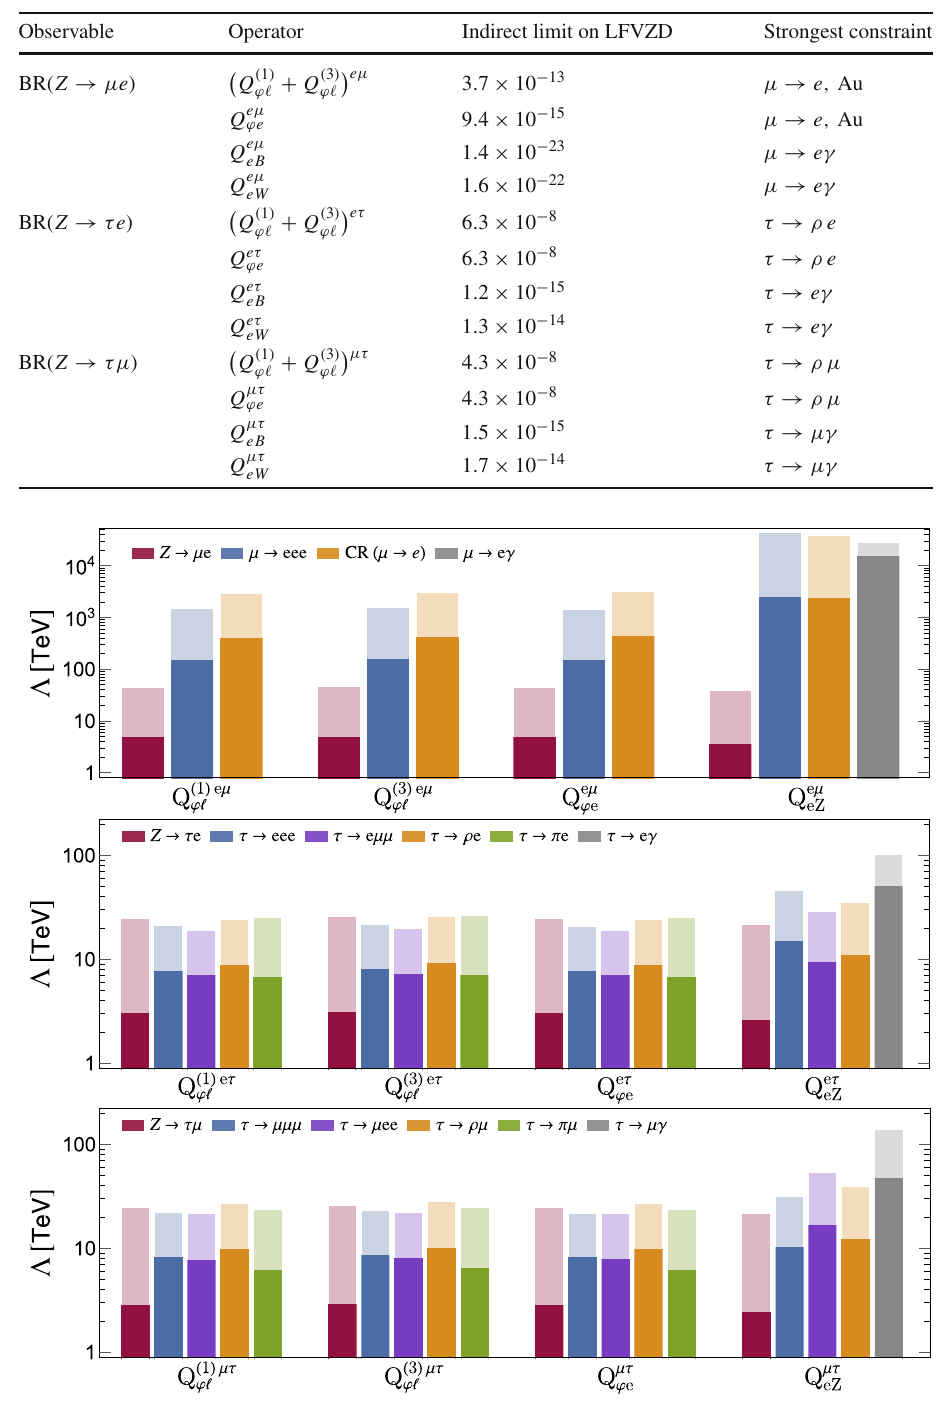
Table 4 Indirect upper limits on BR ( Z → (cid:2) i (cid:2) j ) considering a single operator at the scale μ = m Z . The last column shows which low-energy observable gives the strongest constraint. These indirect limits are to be compared with the future expected bounds at a Tera Z factory shown in Table 1, i.e.